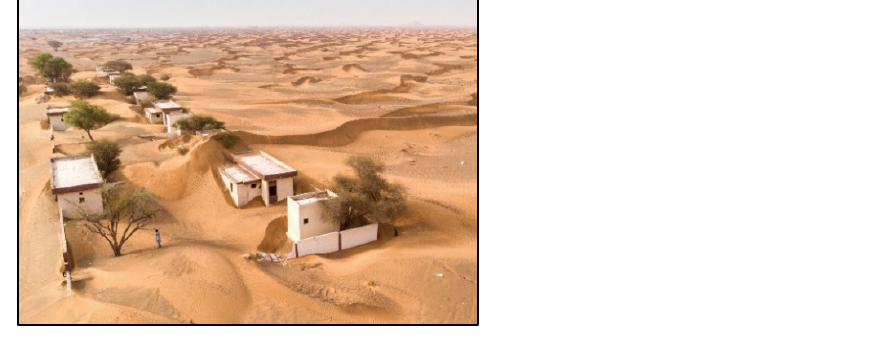
Figure 1. Al ‐ Madam town, UAE. Credit: Shutterstock.com (accessed on 8 November 2022).